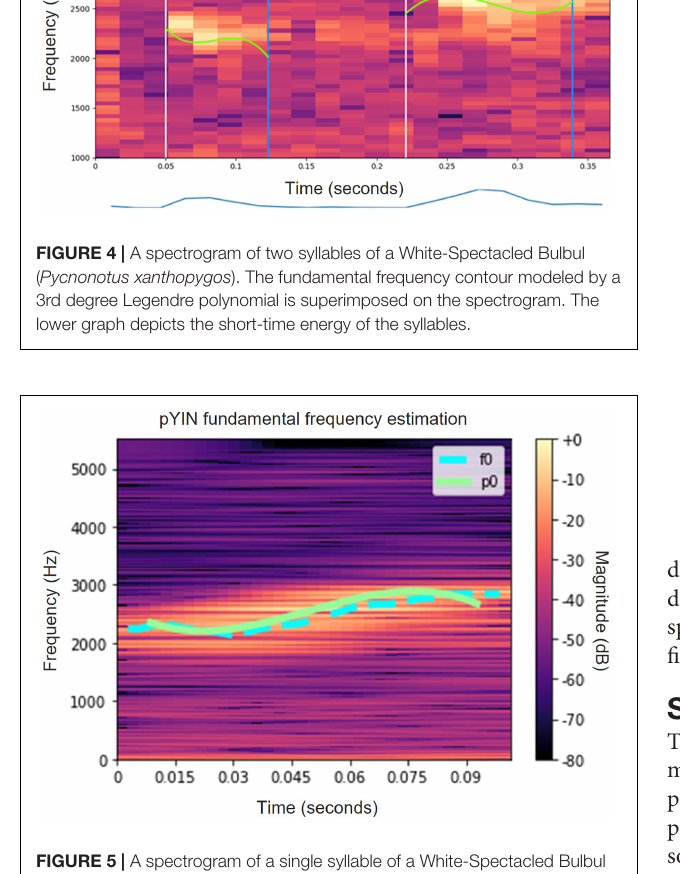
FIGURE 5 | A spectrogram of a single syllable of a White-Spectacled Bulbul ( Pycnonotus xanthopygos ). The fundamental frequency contour is estimated by PYIN (cyan) and by ZCR (light